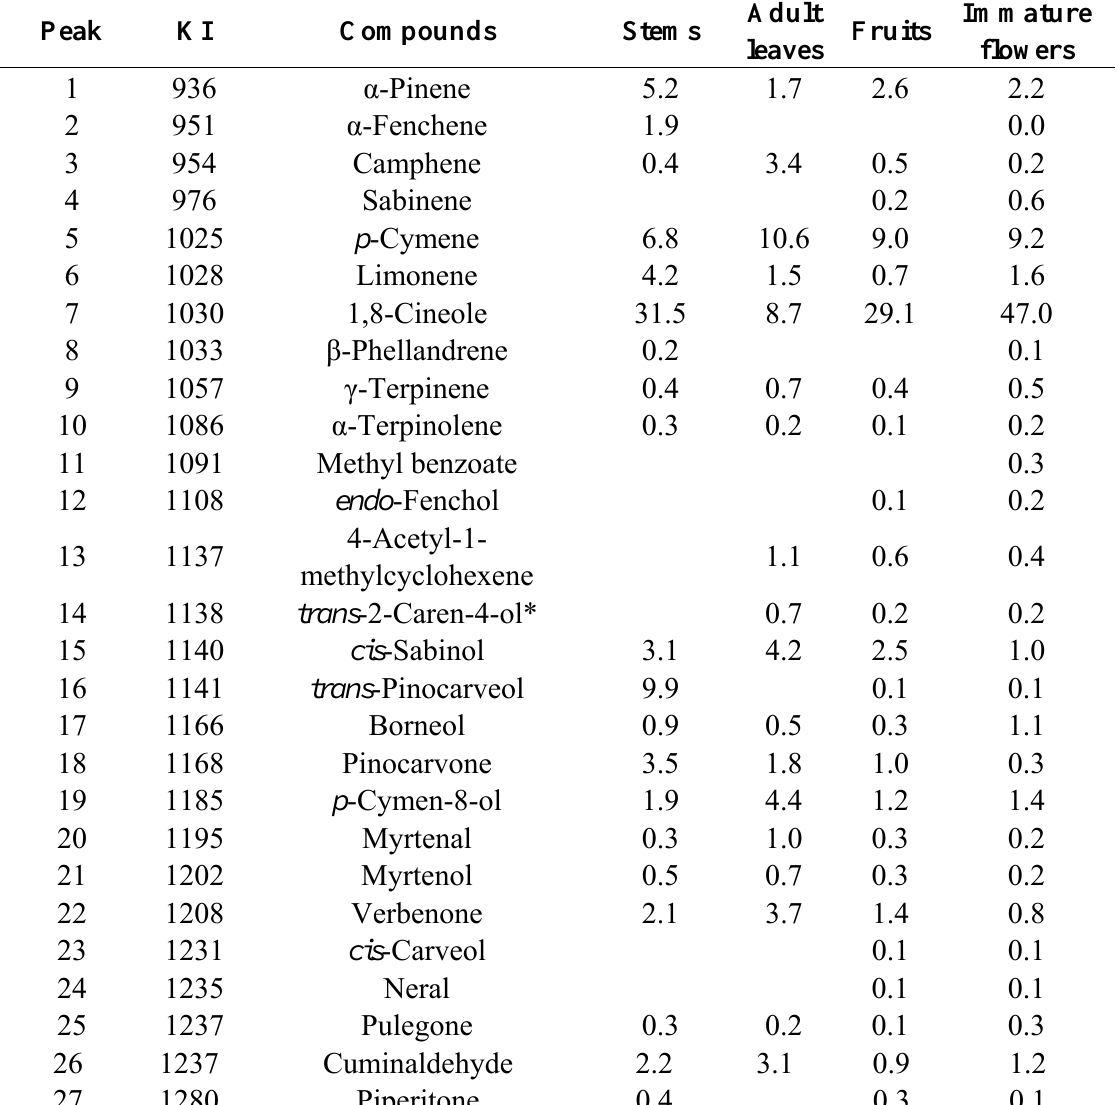
Table 1. Chemical composition of the different parts of E. oleosa essential